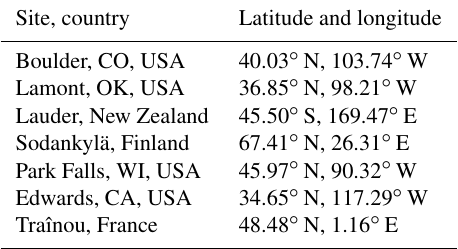
of AirCore sites